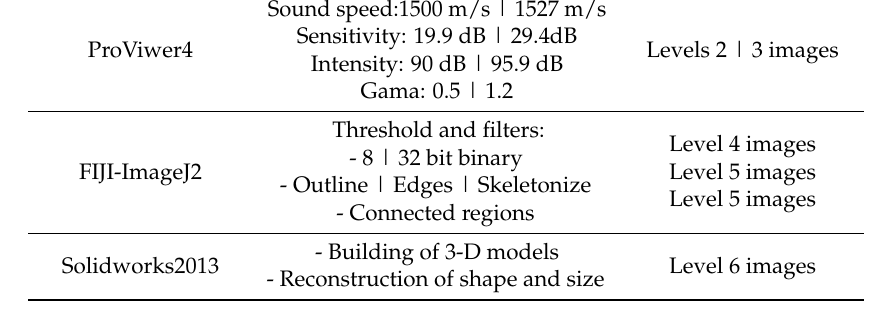
Table 2. The calibration parameters used for processing the images.